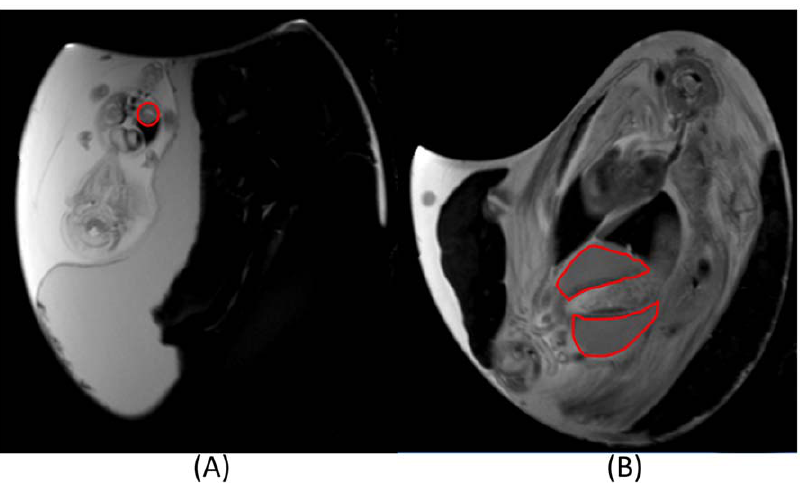
Figure 4. Region of interest (ROI) examples used for DTI fiber tracking. ( A ) At incubation day 9, a single ROI encompasses the entire proventriculus. ( B ) At incubation day 17, two ROIs each cover about half of the gizzard.